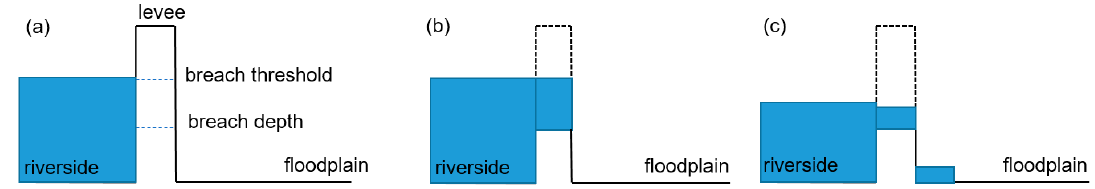
Figure 1. Orthogonal cross-sections of the levee and breach schematics: ( a ) water level in the river